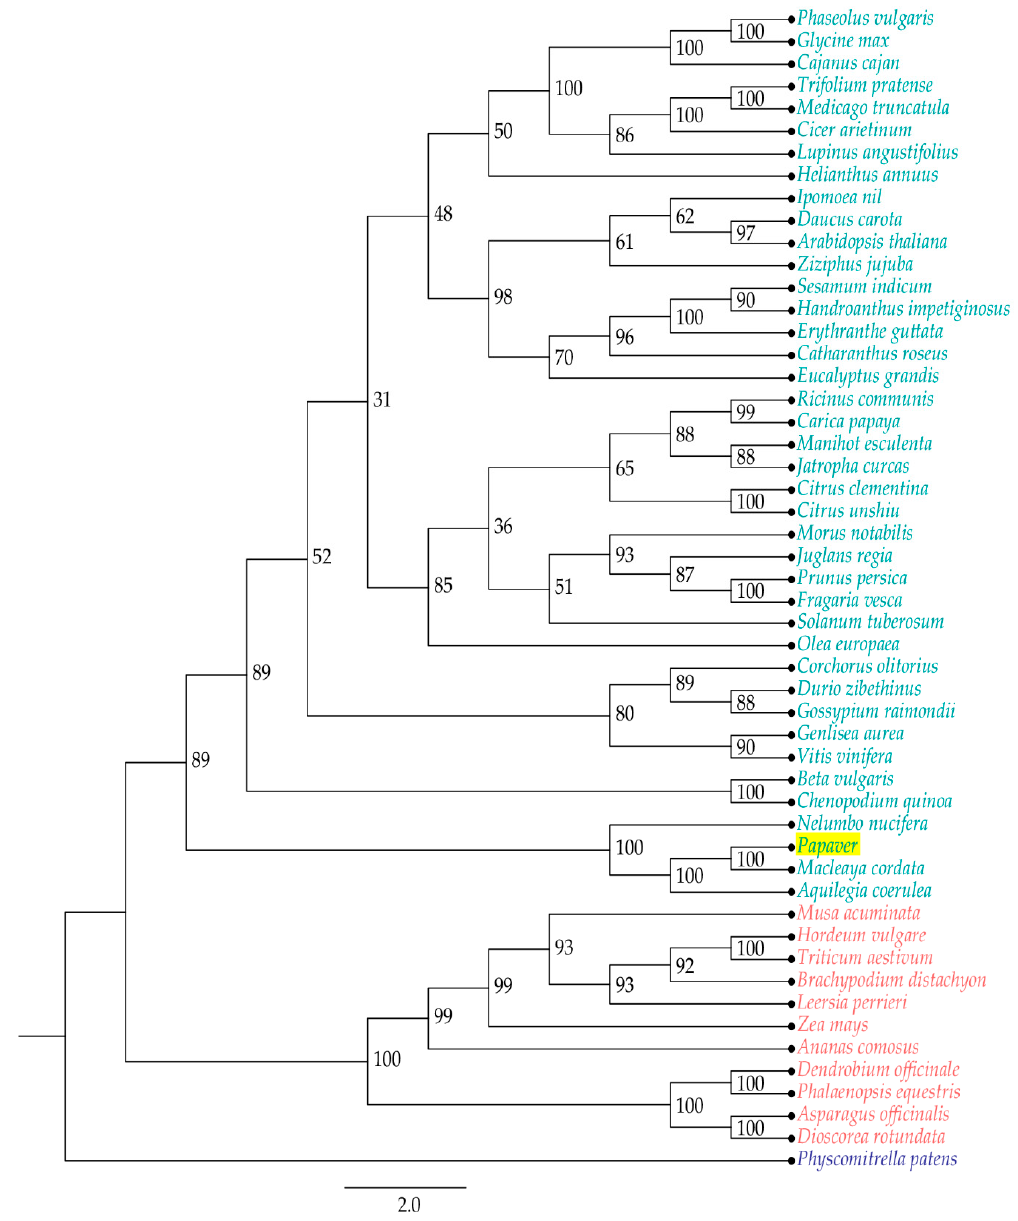
Figure 4. The phylogenetic tree reconstructed to understand evolutionary relationship between Papaver and other selected 51 genomes (see Figure 3 for more details) with respect to secondary metabolite transcripts. This tree constructed with 161 single ‐ copy secondary metabolite biosynthesis responsible transcripts, which includes their isoforms. This tree was re ‐ constructed from 1000 bootstrap trees.